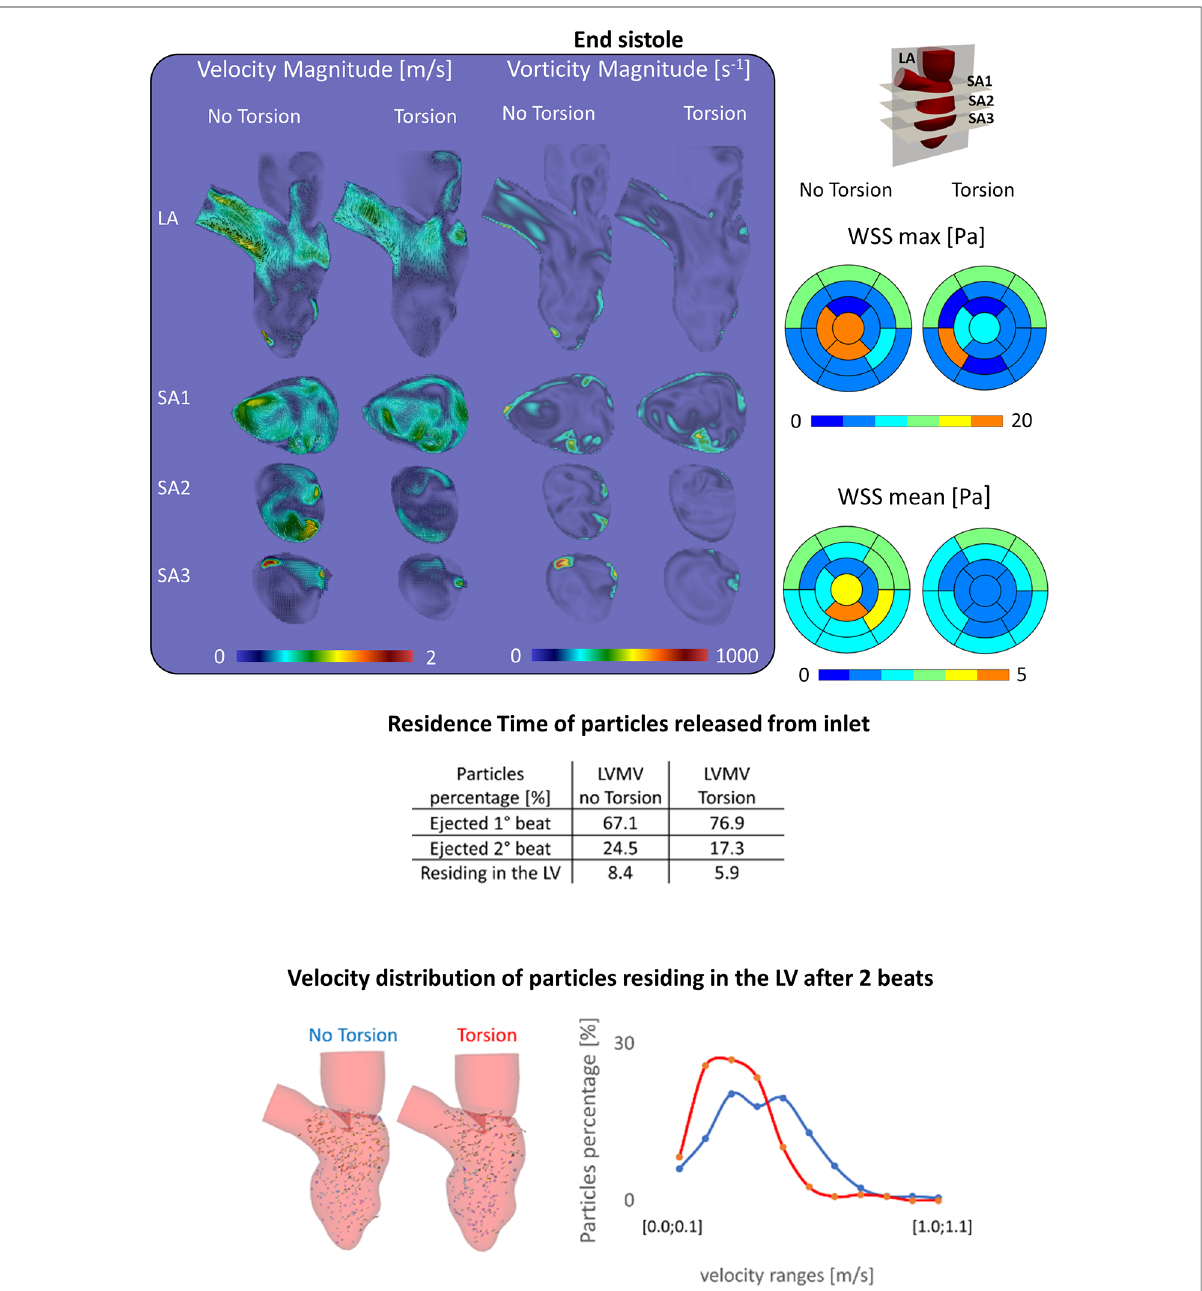
FIGURE 5 (Top) Velocity, vorticity, wall shear stress contours during end systole show a slight increase of these variables in the case disregarding torsion; (middle) the percentage of particles ejected is higher in the torsion case (+9.8%), nonetheless after two beats the difference decreases below 3%; (Bottom) the case without torsion induces a better motility of the particles residing in the left